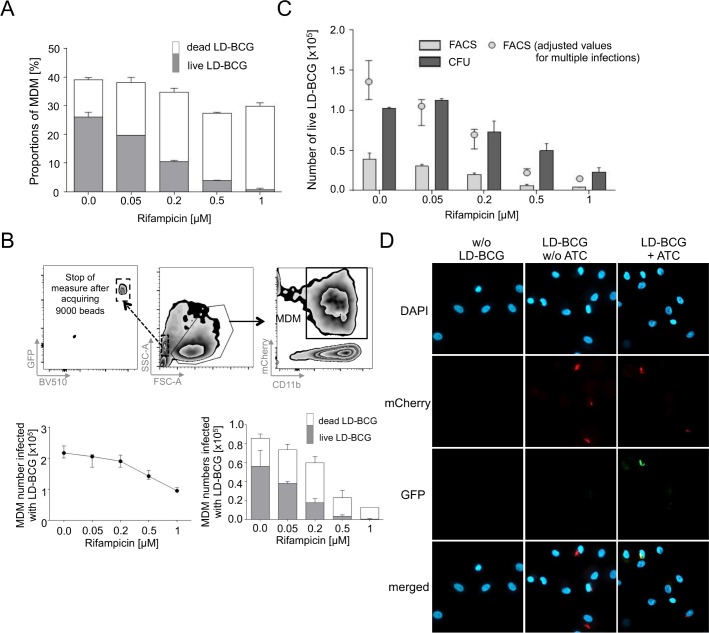
Proportional and absolute differences of LD-BCG infected MDM and comparison with Colony Forming Units (CFU) and fluorescence microscopy.Rifampicin treatment of MDM infected with LD-BCG at different indicated concentrations is shown. (A) Flow cytometry (FACS) analysis of MDM proportions infected with live (grey) or dead (open) LD-BCG are shown as stacked boxes. (B) Comparison of absolute MDM numbers infected with LD-BCG measured by bead corrected flow cytometry. Bead-based standardization of measured sample volume is shown in the upper graphs. Absolute numbers of all infected MDM (lower left graph) as well as MDM containing live and dead LD-BCG (lower right graph) at different rifampicin concentrations are shown. Median with range of triplicates are depicted. (C) Comparison of live LD-BCG infected MDM numbers measured by FACS and mycobacterial culture (CFU). Circles indicate FACS values adjusted for multiple infections as determined by fluorescence microscopy. Median values with range of triplicates are depicted. (D) Fluorescence microscopy analyses of MDMs infected with LD-BCG with or w/o ATC or non-infected MDM are shown. Blue color indicates MDM nuclei; red color indicates mCherry expressing LD-BCG; green color indicates GFP-expressing live LD-BCG. A representative experiment of three is shown.